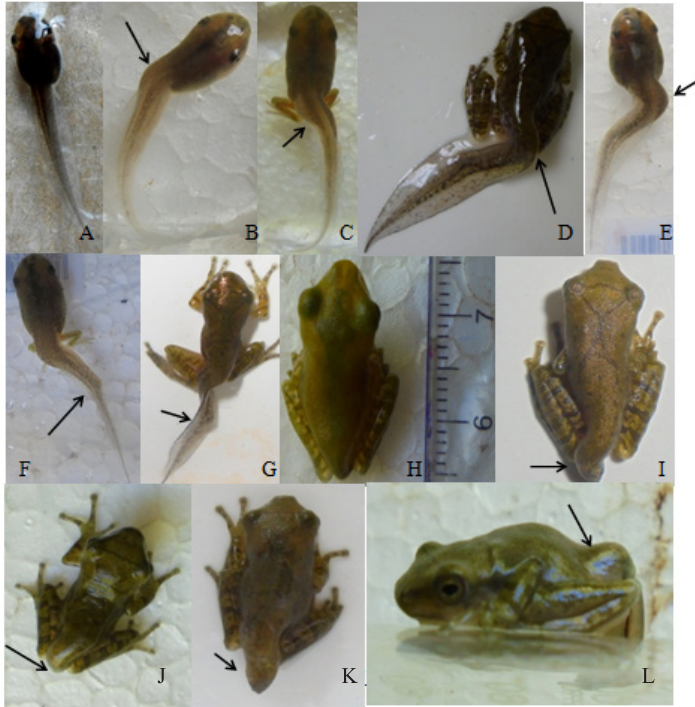
Figure 7: Tadpoles of Polypedates cruciger exposed to cercariae type H at Gosner stage 27/28. A) Uninfected normal tadpole; B to D) infected tadpoles at different developmental stages with kyphosis (hunched back or abnormal curvature of the spine in the dorso-ventral plane); E to G) with scoliosis (abnormal curvature of the spine in the lateral plane); H) normal metamorph; I and J) metamorphs with scoliosis (Note the malformation is absent in adult); K and L) metamorphs with kyphosis at 30/31 (A,B,E), 38/39 (C,F), 41/42 (D,G),44/45(I,J,K) Gosner stages, Complete metermorphosis (H, L).